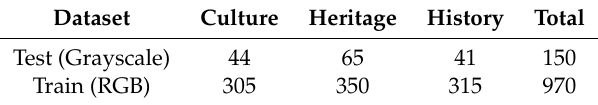
Table 1. Cultural, Heritage, and Historical Image